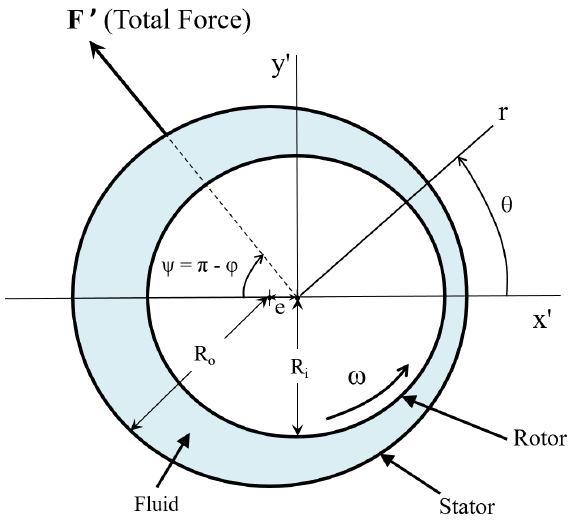
Figure 2. Sketch of two-dimensional journal bearing. The angular velocity of the rotor ω = constant. The angle ϕ is the angle between the force F (cid:48) and the positive x (cid:48) axis. The angle ψ ≡ π − ϕ